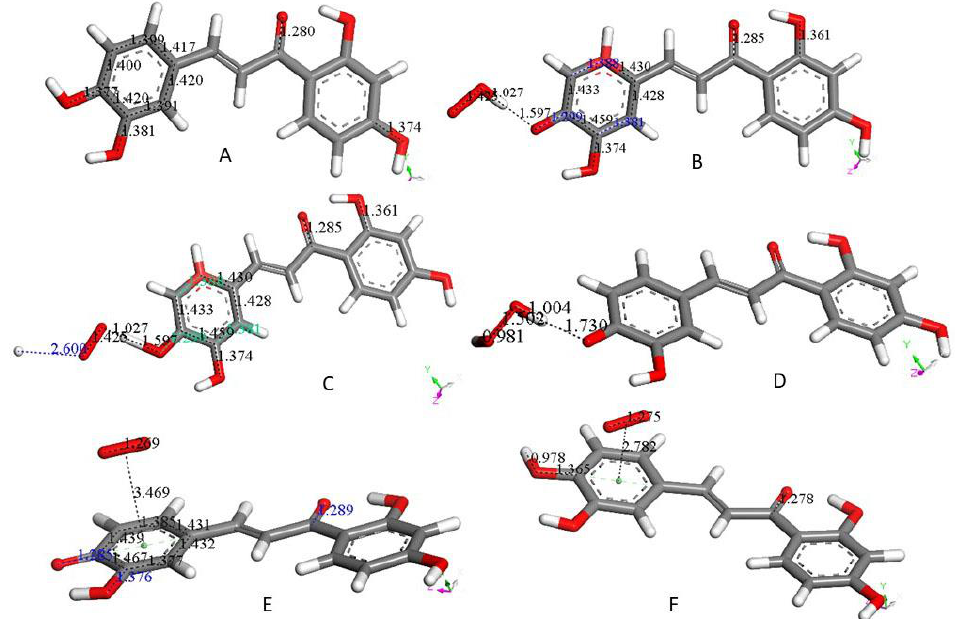
Figure 3. ( A ): The DFT geometry minimization of butein X-ray crystal structure coordinates produces this minimum energy structure. C–C bond distances of interest are indicated for comparison with related structures. ( B ): After posing a superoxide radical at van der Waals separation, 2.60 Å, from the butein H(hydroxyl) in position 4, DFT geometry optimization indicates superoxide capturing an H atom from butein [O(superoxide)–H(butein), 1.027 Å] and forming the HO 2 − anion. The remaining polyphenol has an unpaired electron located in the ring. C4–O4 = 1.299 Å (blue) with an intermediate value between a single C3–O3 bond (1.374 Å) and the C=O double bond (1.285 Å) adjacent to ring A, right. That is, C4–O4 has some double bond character which markedly influences the associated ring B, determining an extended double bond conjugation, with a sequence of long [C4–C5 (1.433 Å), C3–C4 (1.459 Å), short C2–C3 (1.381 Å, blue), C5–C6 (1.388 Å, blue), long C1–C2 (1.428 Å) and C1-C6 (1.430 Å ) bonds. ( C ): The butein – superoxide arrangement shown in ( B ) is now